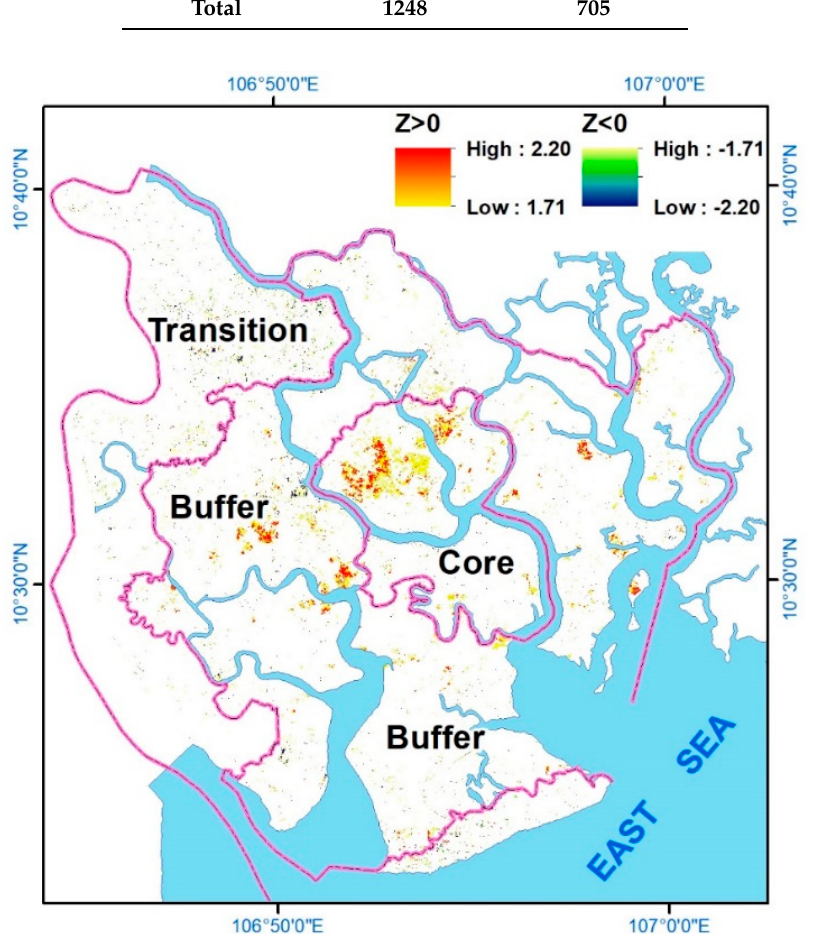
Figure 5. Spatiotemporal changes in mangrove population during the study period in Can Gio ( p < 0.05 ). Table 6. The significant changes in mangrove area through three ecological zones from 2015 to 2019 (ha). Zones Increase Decrease